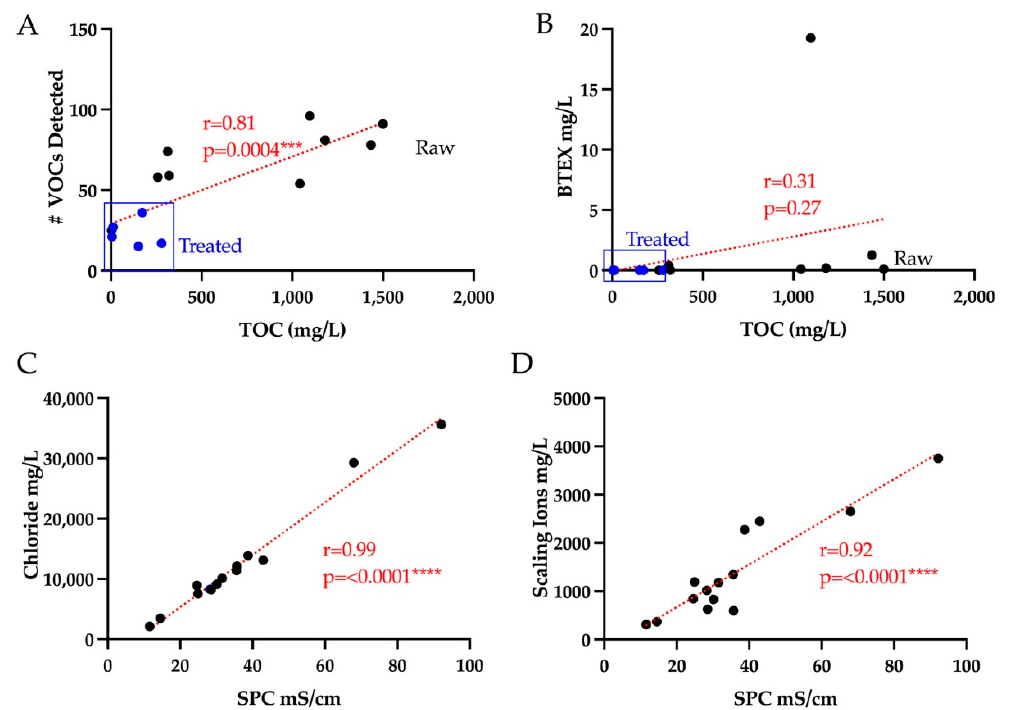
Figure 2. Correlative analysis of pertinent constituent classes and bulk measurements. ( A ) Total organic carbon (TOC) concentrations in relation to the number of volatile organic compounds (VOCs) detected in treated and untreated produced water from the Eagle Ford Shale region [5]. ( B ) TOC concentrations in relation to total BTEX concentrations (benzene, toluene, ethylbenzene, and m,p,o-xylenes). ( C ) Specific conductivity (SPC) measurements in relation to the concentrations of chloride ions. ( D ) SPC measurements in relation to the cumulative concentrations of the scaling ions barium, calcium, magnesium, and strontium. It is important to note that the efficacies of oxidation, particulate filtration, two different carbon medias, and UV treatment were evaluated in this study. Desalination modalities were not evaluated. *** and **** denote p-values less than 0.0005 and 0.0001, respectively. Table 1. Hypothetical examples of the possible relationships between TOC, conductivity, acute and chronic toxicities, and the presence of various organic and biological constituents found in FPs of varying water quality. OX: oxidizing agent, PF: particulate filtration, C: carbon filtration, RO: re- verse osmosis, FD: flash distillation, CAV: cavitation, SD: solar distillation.